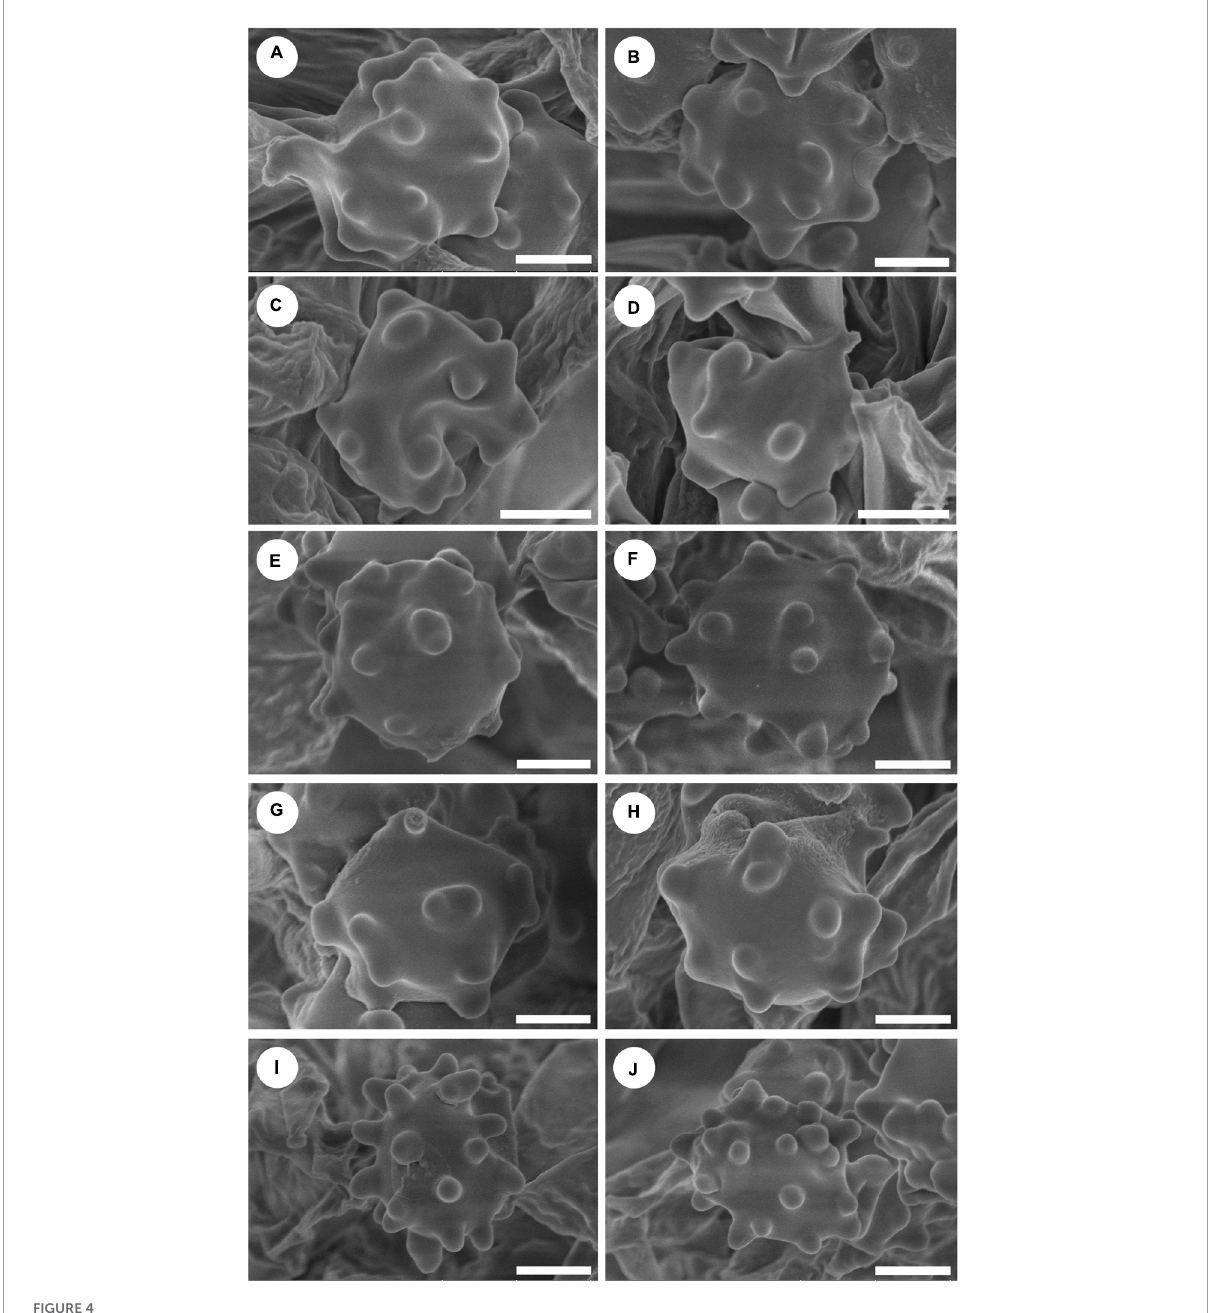
FIGURE4 Scanning Electron Microscope (SEM) of basidiospores of Hydnellum species. (A,B) H. chocolatum , (C,D) H. concentricum , (E,F) H. crassipileatum , (G,H) H. melanocarpum , and (I,J) H. radiatum Scale bars: 1.5 µ m.